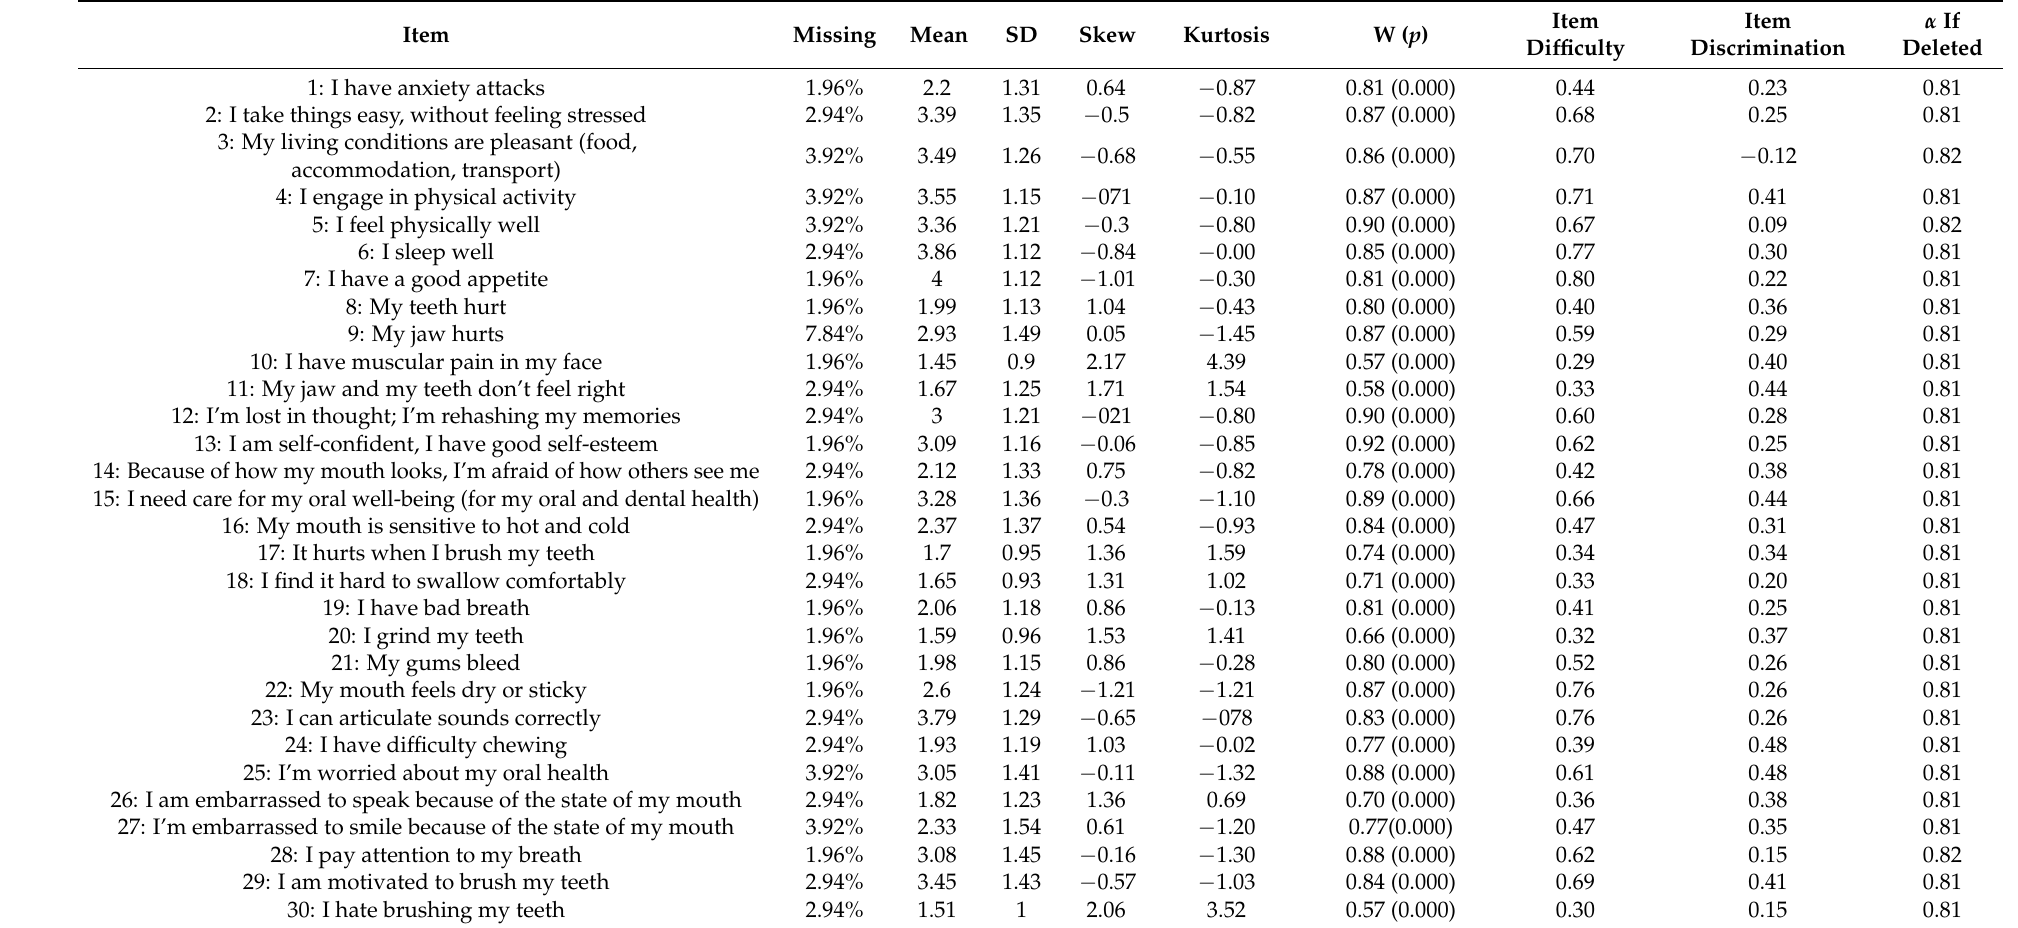
Table 3. Rasch analysis of the SOHP (42